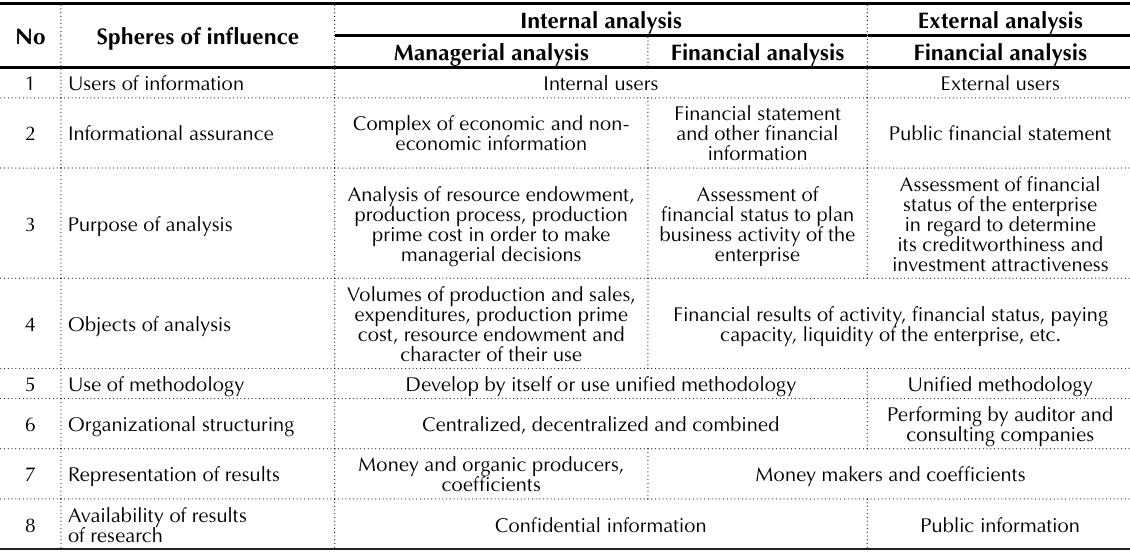
Source: Developed by the